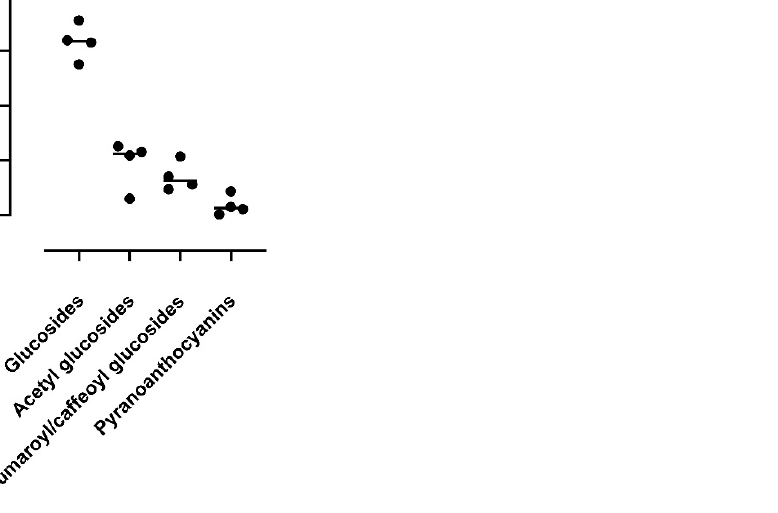
Figure 7. Variability of anthocyanin derivatives found in the four samples. For each sample, individual values are reported together with mean and SD.